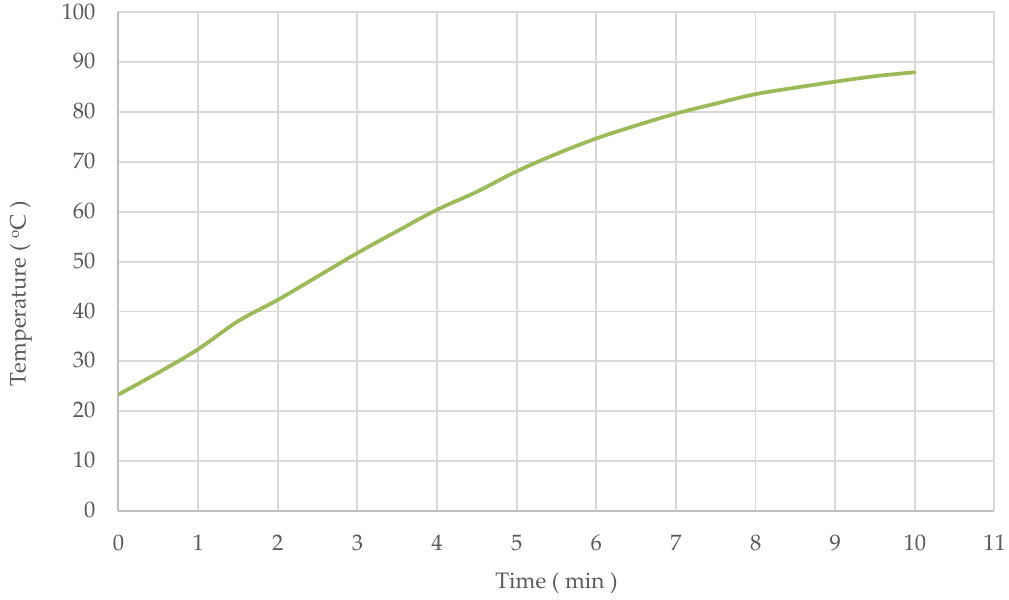
Figure 6. Temperature change during UAE for stevia powder suspension (750 W, 12.75 mm, 20 kHz, 100% amplitude).